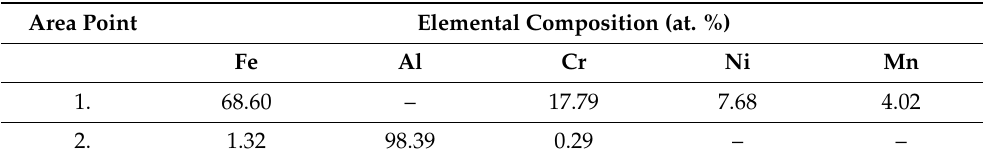
Table 4. The EDS analysis of the AISI 304L samples after aluminizing (point area 2) in comparison to the substrate (point area 1). Please refer to Figure 2a for point area details.